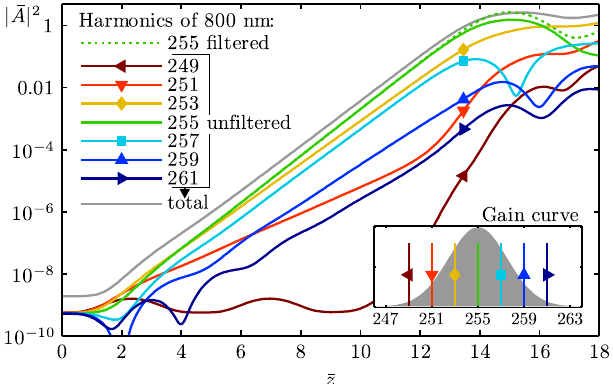
FIG. 5. Evolution of HHG seed harmonics around the FEL- resonant 255th harmonic of an 800 nm driving laser, for the cases of a full and a filtered seed. The full seed (cf. Fig. 3) contains several harmonics that fall within the gain bandwidth ( (cid:4) ¼ 5 (cid:6) 10 (cid:5) 3 ), whereas the filtered seed case contains only the 255th harmonic. Spectral components of FEL output resulting from the full seed are represented by solid lines, where the gray line is total normalized field due to harmonics 249 through 261; the output from the filtered seed is represented by the dotted green line. Inset: harmonic content of the full seed (vertical lines), set against the FEL gain bandwidth (gray).